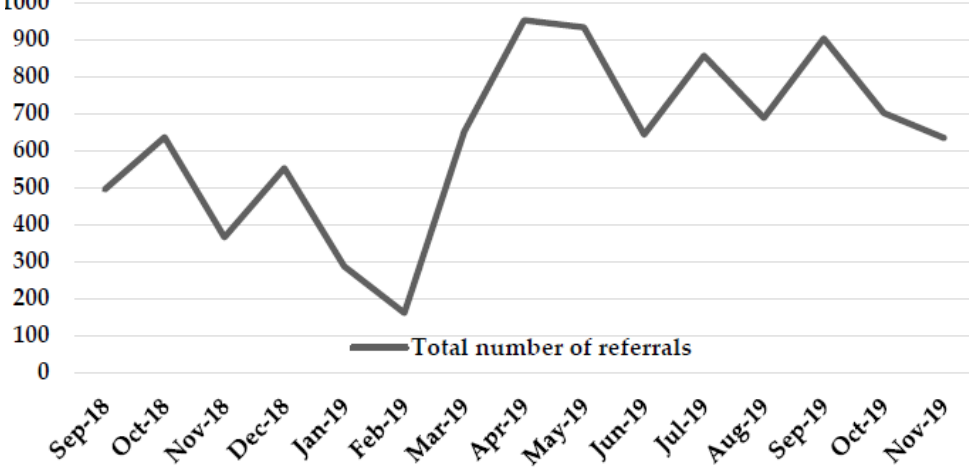
Figure 2. Roswell Park Tobacco Treatment Service Clinic Referral Volume.